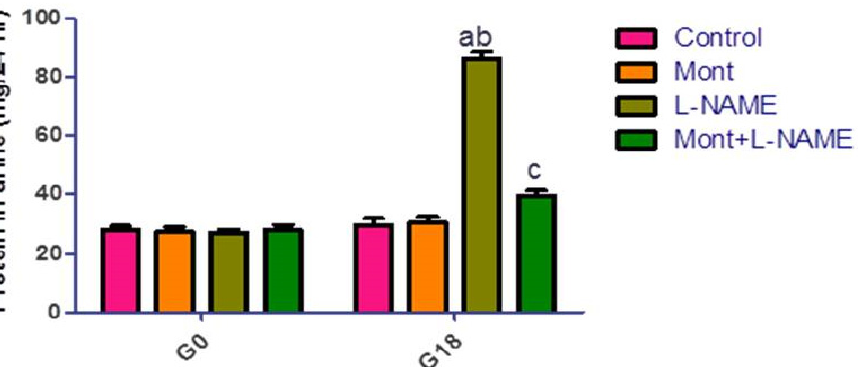
Figure 2. Effect of montelukast on 24 h urine protein in a pre-eclampsia model in rats. rats/group). (a) Significant ( p < 0.05) difference from the control group. (b) Significant ( p < 0.05) difference from the Mont group. (c) Significant ( p < 0.05) difference from the L-NAME group. [Mont: montelukast; L-NAME: L-NG-Nitro arginine methyl ester].